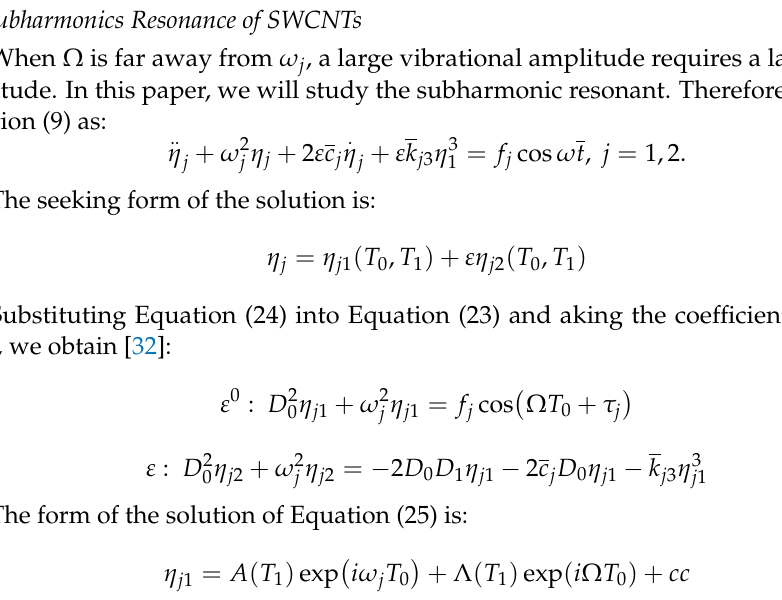
( ) ( ) σ = , 5,20 c . Figure 9. Excitation amplitude response curves of the second mode with ( c 2 , σ ) = ( 5,20 ) 2